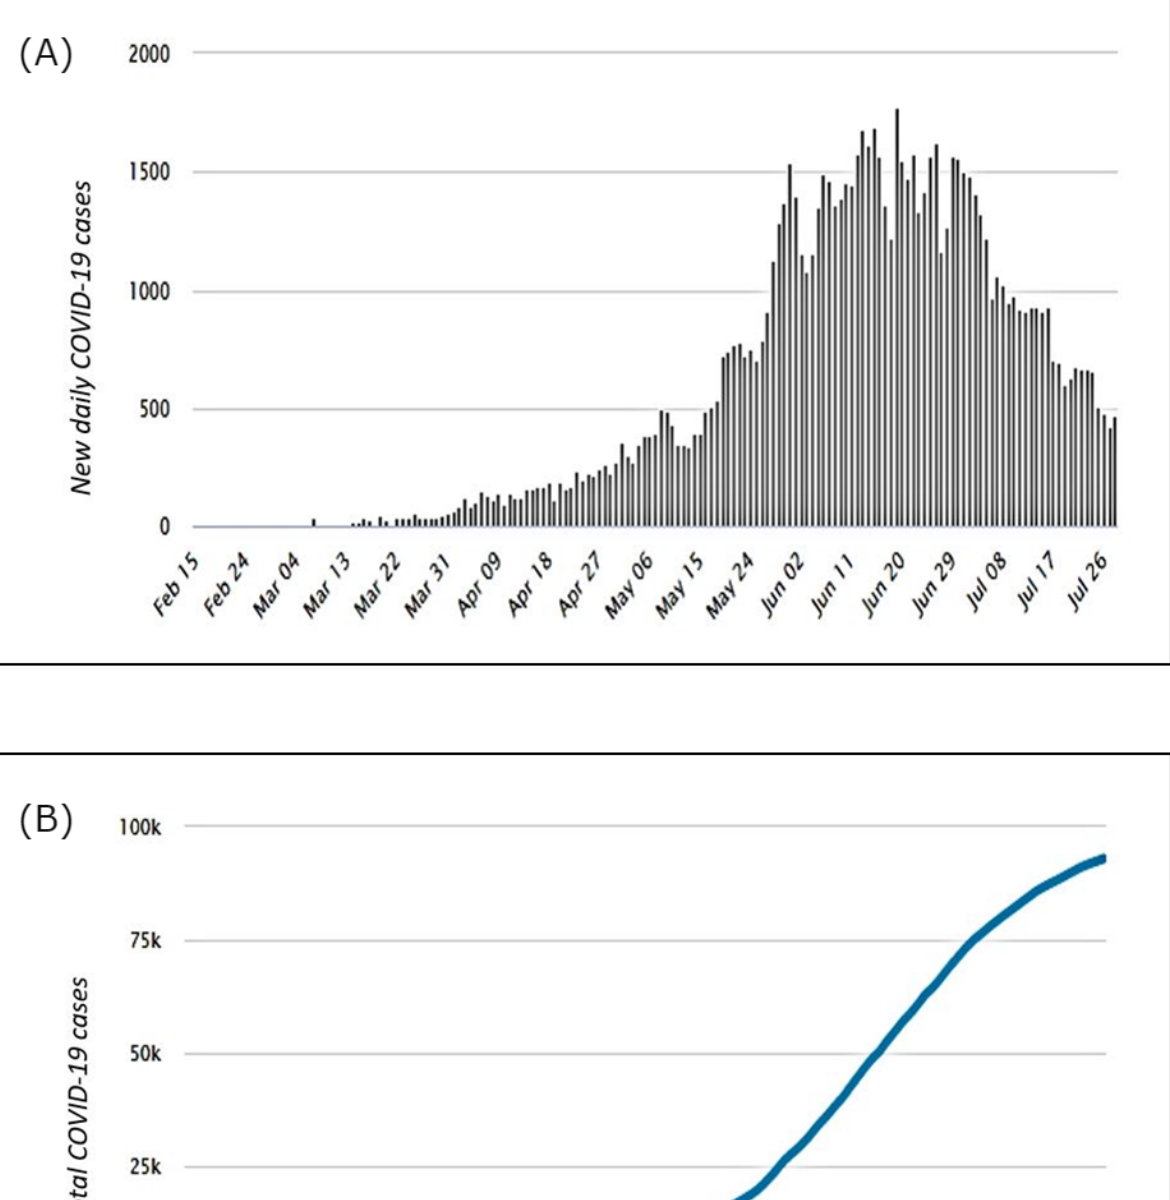
Figure 1. (A) Daily new and (B) total numbers of COVID-19 cases in Egypt from February to July 2020